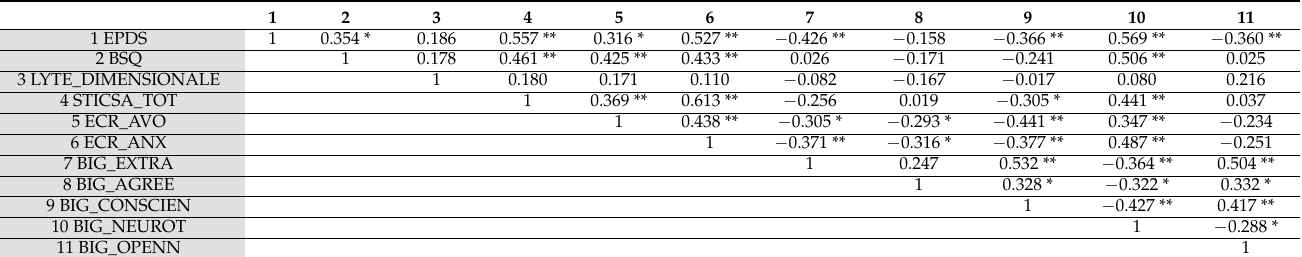
Table 4. Correlations of the key variables in the